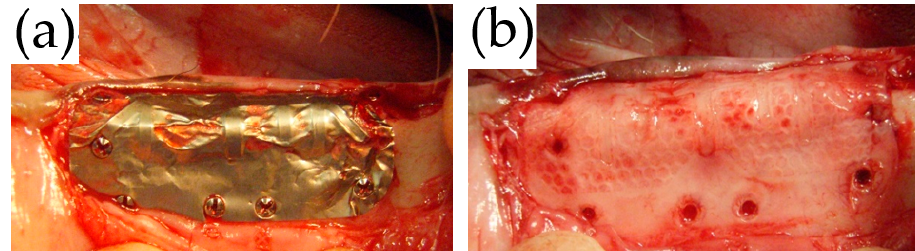
Figure 7. Macroscopic observation at membrane removal in the TiHM group. ( a , b ) There was no adhesion of the membrane to the surrounding tissue, and the membrane was able to be peeled back with ease. The bone surfaces in contact with the laser-processed sections showed unprocessed sections and honeycomb-shaped compartments, which were clearly colored red.